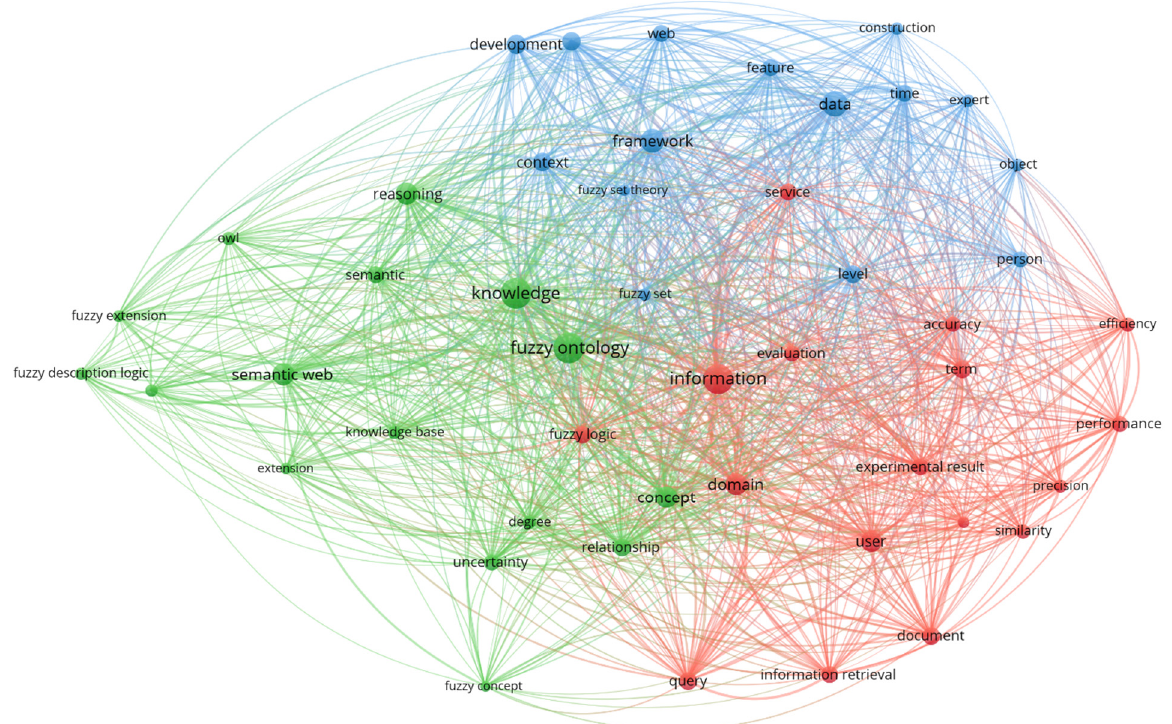
Figure 3. The most occurring keywords map.